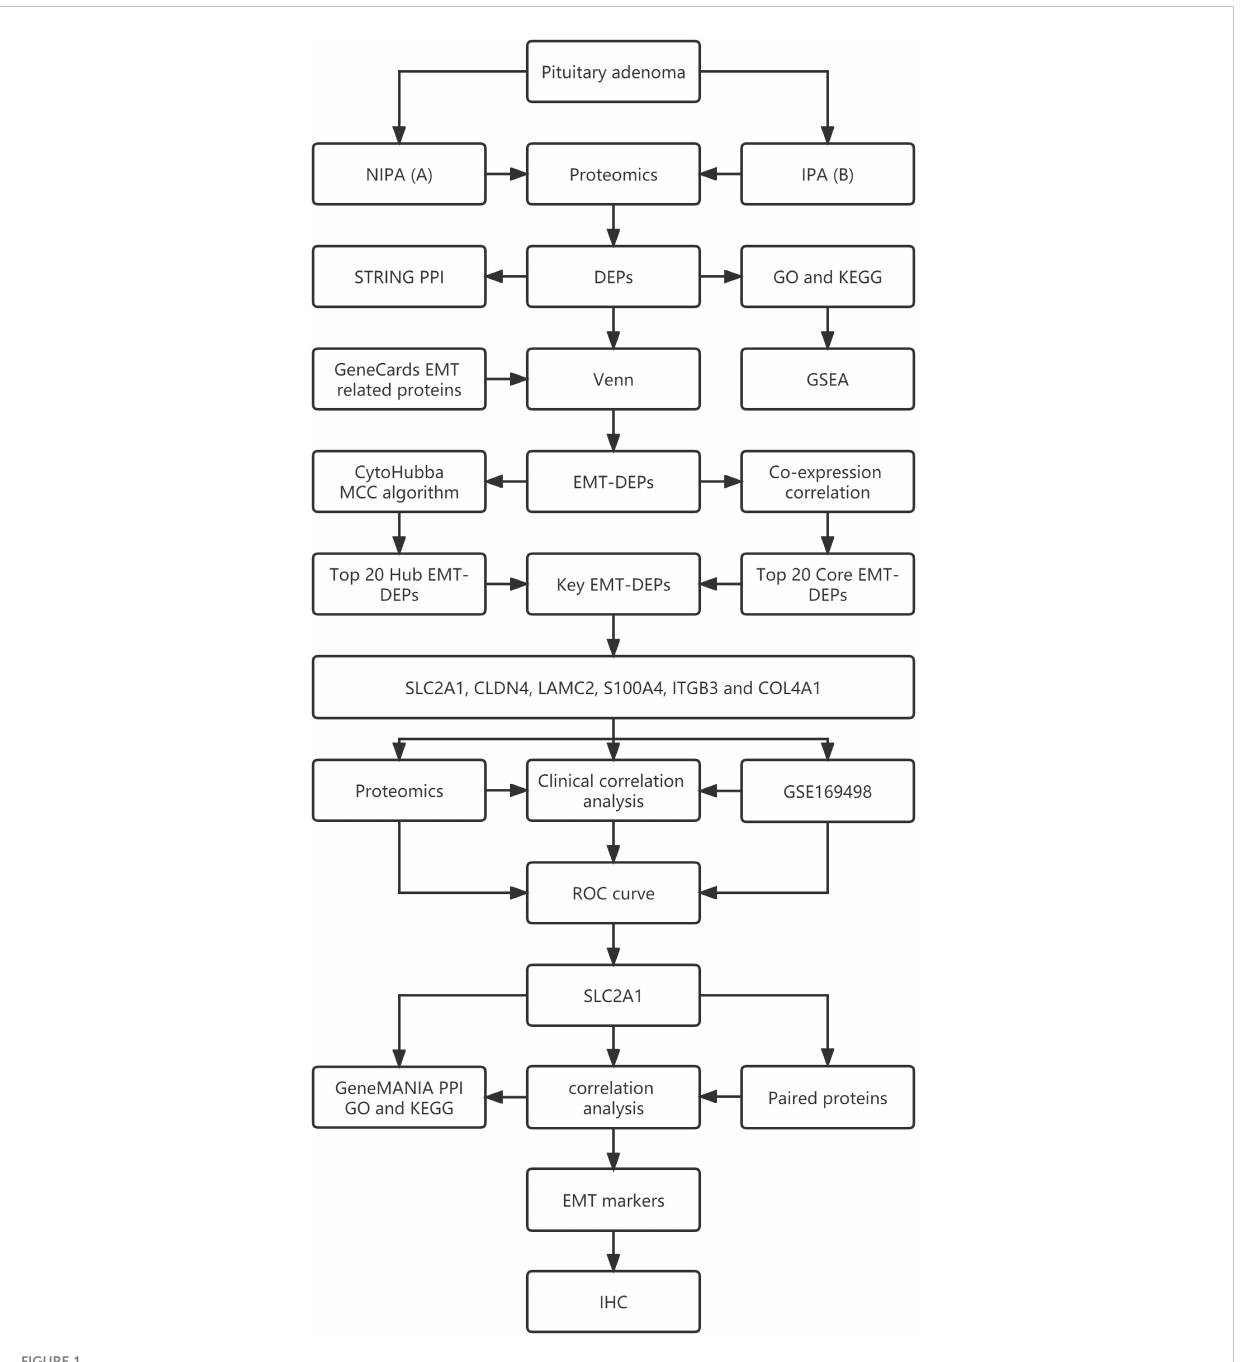
FIGURE 1 The fl ow chart of this